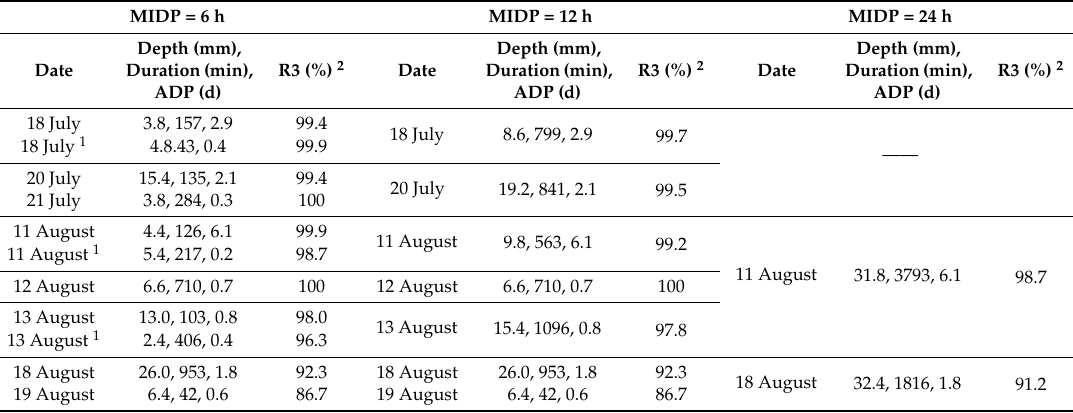
Table 3. Rainfall events affected by MIDPs during the monitoring